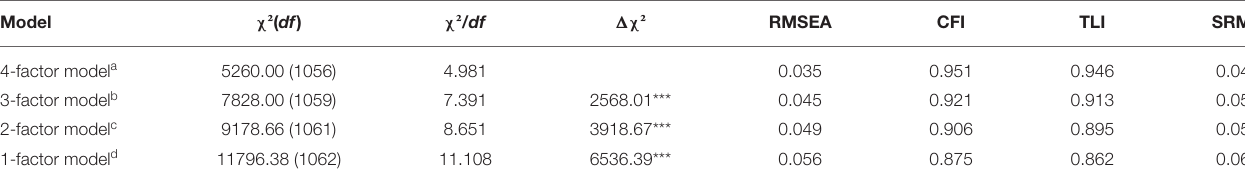
TABLE 1 | Confirmatory factor analysis. Model